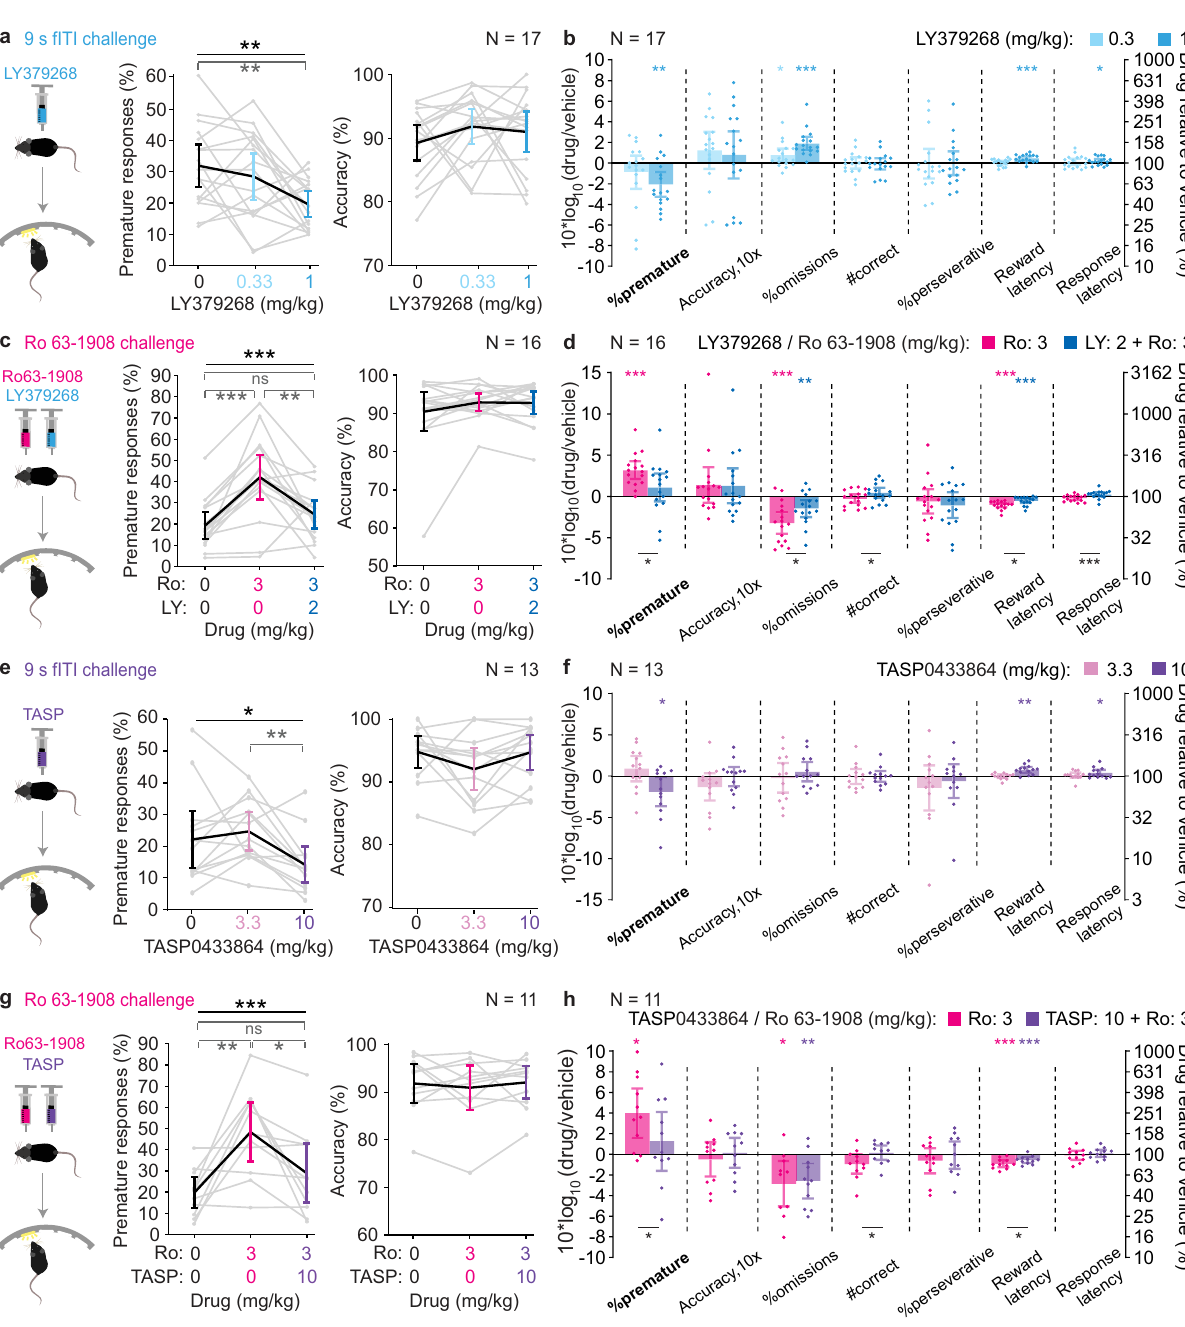
Fig. 6 Reduction of impulsivity by the mGluR2/3 agonist LY379268 and the mGluR2-PAM TASP0433864. Absolute values of %premature responses (left) and attentional accuracy (right) after injection of vehicle (0) or various doses of LY379268 (LY; a , c ) or TASP0433864 (TASP; e , g ), as indicated, in the parametric 9s fITI ( a , e ) or pharmacological Ro 63-1908 (Ro, c , g ) challenge conditions. The same group of 18 male C57BL/6 mice was used for every LY-experiment and the same group of 13 male C57BL/6 wildtype mice was used for every TASP-experiment with contributing N -numbers indicated in the accuracy panels. Black stars indicate signi fi cant effects of dose; grey stars indicate signi fi cant paired post-hoc comparisons between dose-levels (Sidak). ( b , d , f , h ) Drug-induced changes in the corresponding experiment identi fi ed in a , c , e , g measured as log 10 -transform of the within-subject ratio (value after drug(s)/value after vehicle) for relevant behavioural performance parameters on the 5-CSRTT are shown for the tested doses and drug combinations as indicated in the colour legend. Asterisks indicate one-sample t -tests against 0, colour-coded according to the dose. For the Ro-challenges ( d , h ), the results of paired t -tests between the two drug conditions are also indicated by black asterisks below bars. See Supplementary Tables 10, 11 (for LY) and 13-14 (TASP) for statistics, further analysis, and reasons for varying N -numbers across experiments. N -numbers are stated in each panel. * P < 0.05; ** P < 0.01; *** P ≤ 0.001; error bars, C.I.; individual dots or dot-lines represent